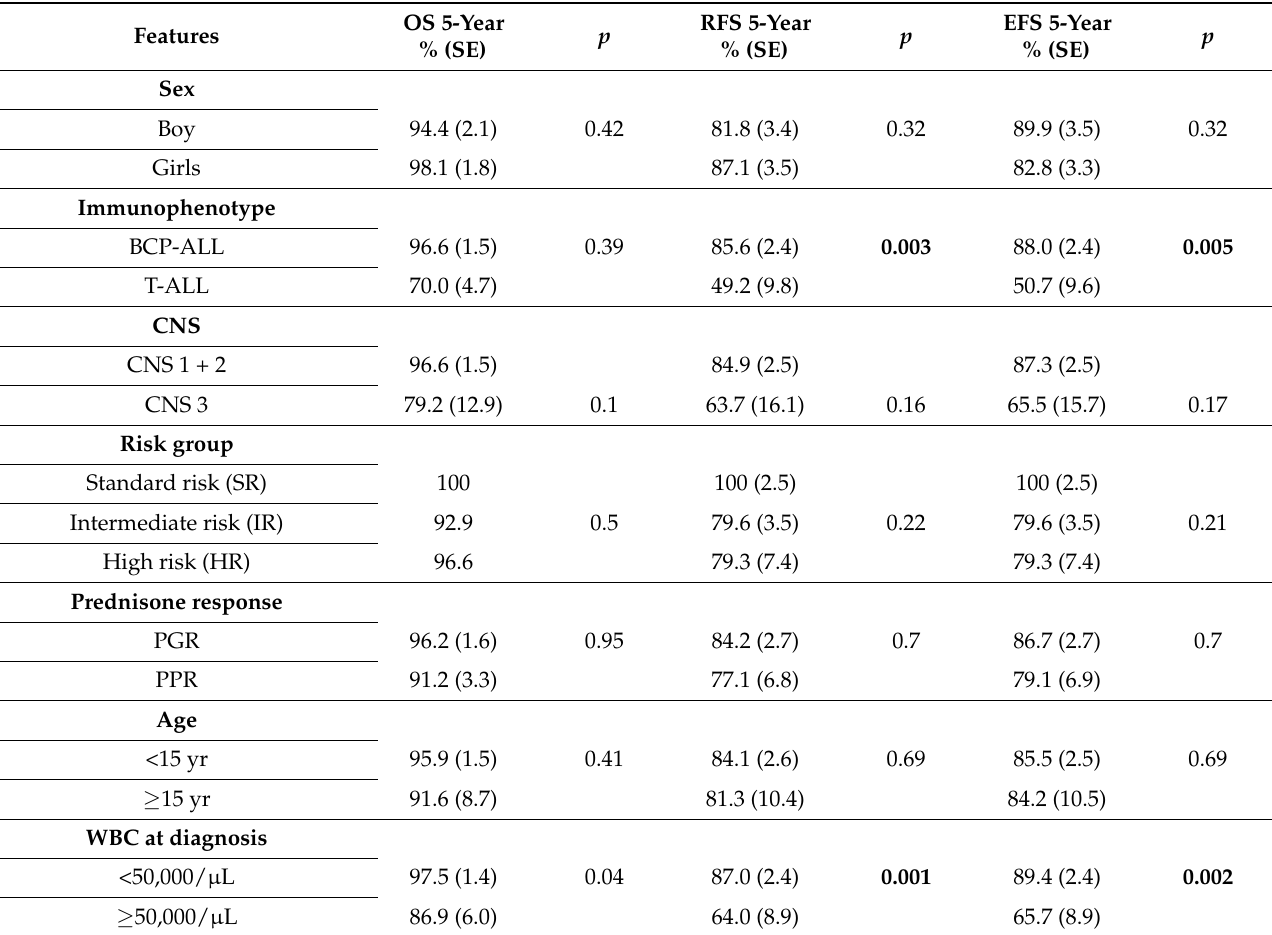
Table 4. Outcome data by patient characteristics for children treated according to ALL IC-BFM 2009